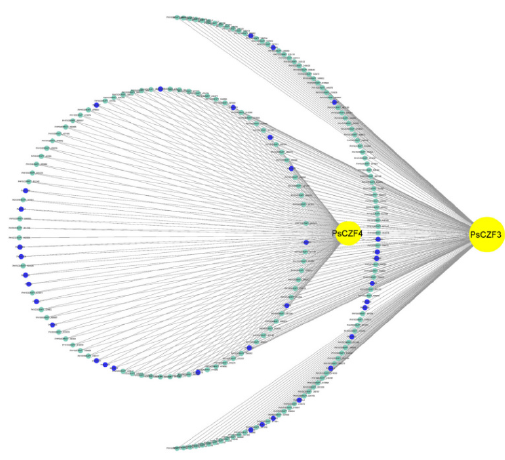
Figure 3. Network of transcription factors–effector interactions in the red modules. Yellow dots represent transcription factors, green dots indicate the correlated genes, and blue dots denote RxLR effector genes. The network was constructed by Cytoscape v3.7.2.